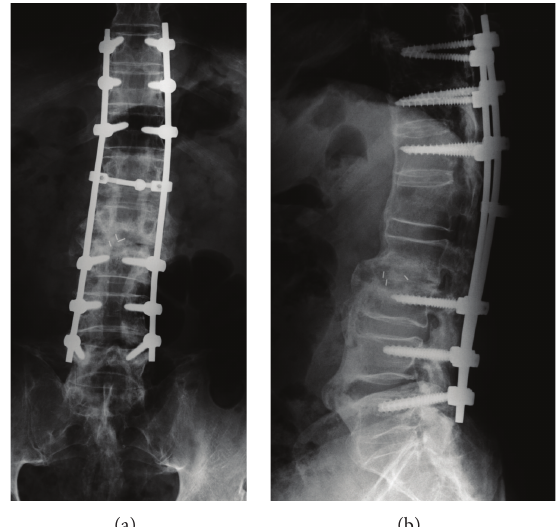
Figure 5: (a) Frontal and (b) lateral images obtained at 18 months after the second surgery, showing no loosening of pedicle screws and favorable bone adhesion in PLIF and